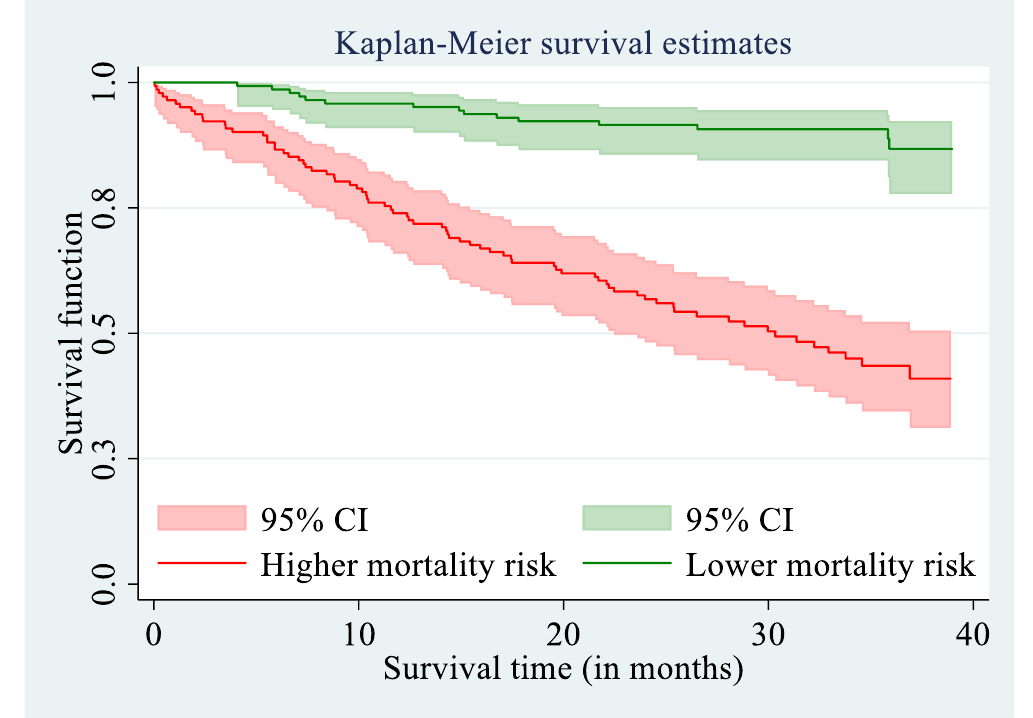
Figure 4. Kaplan–Meier survival curves for patients assigned to a higher and a lower mortality risk category based on a 10-fold cross-validation. Results of the multivariable Cox PH model with the same seven most important risk factors for mortality rate identified by both: The stepwise backward variable selection and the iterative BMA approach.